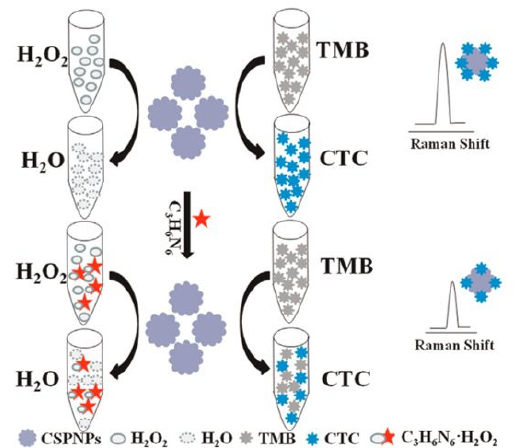
Figure 22. Working mechanism for the determination of melamine in milk powder using a Ch–Au nanozyme with Surface Enhanced Raman Scattering detection (SERS). Reprinted with permission from [77]. Copyright © 2015 Elsevier.